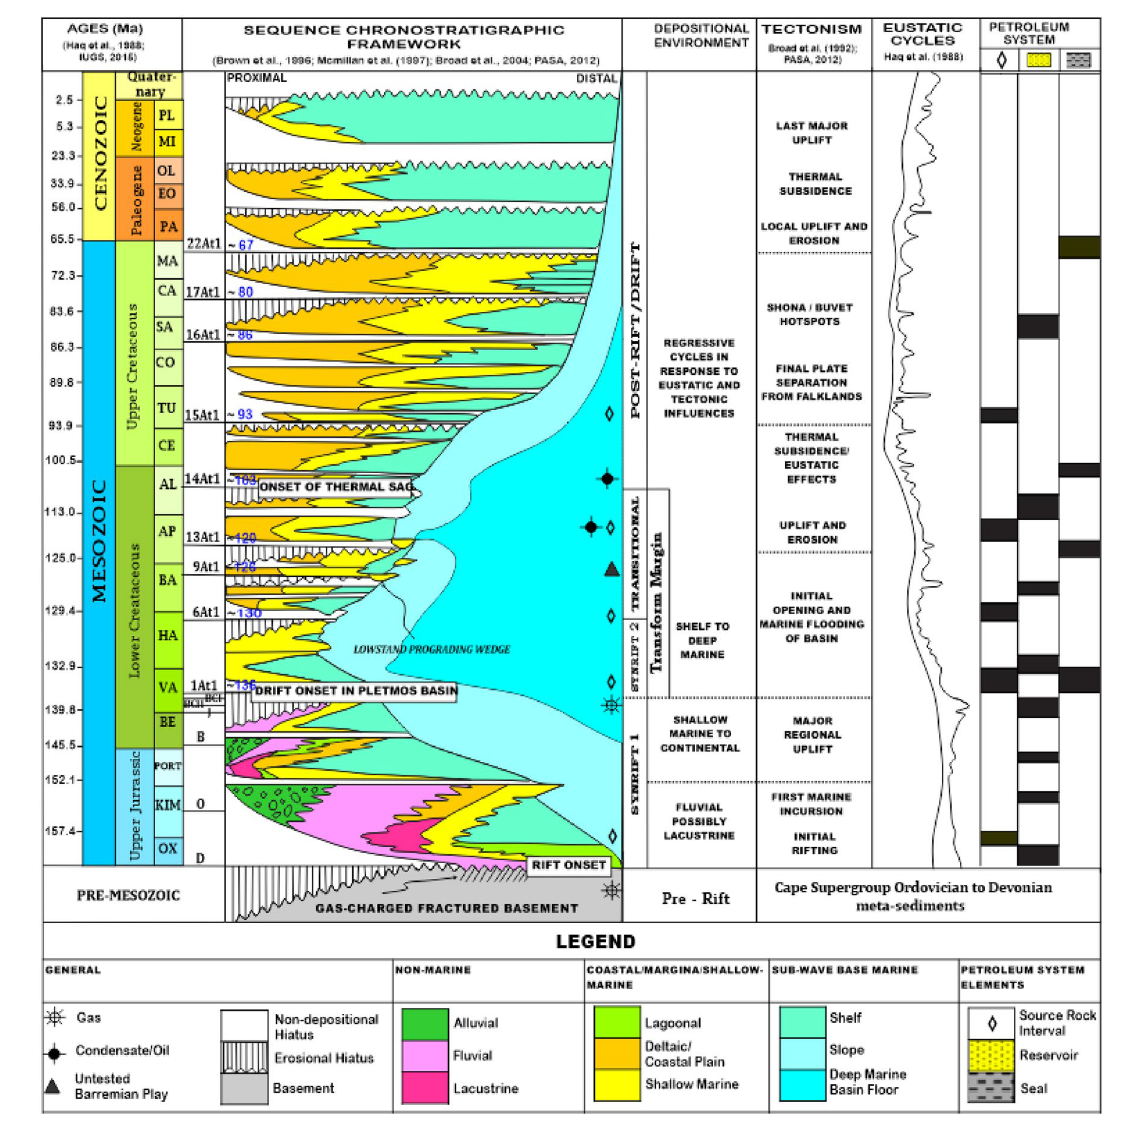
Fig. 3 Chronostratigraphic chart of the Pletmos Basin showing the major depositional and tectonic events in the basin and the prog- nosed petroleum system elements modified after Brown et al. (1996). The current basin-fill structure is derived from previous research